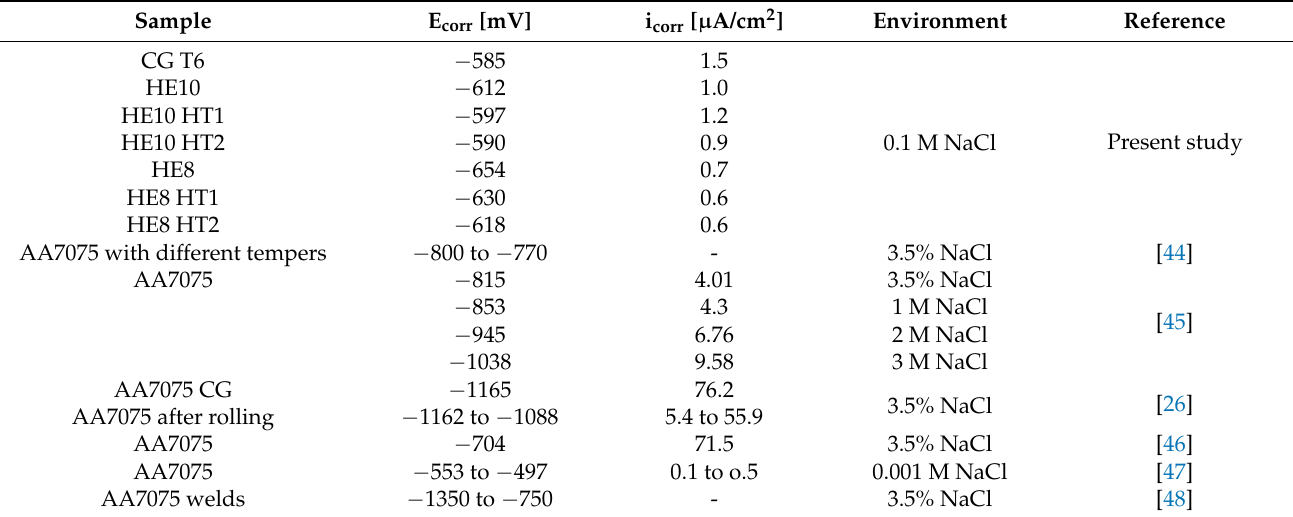
Table 4. Results of electrochemical properties with comparison to the literature